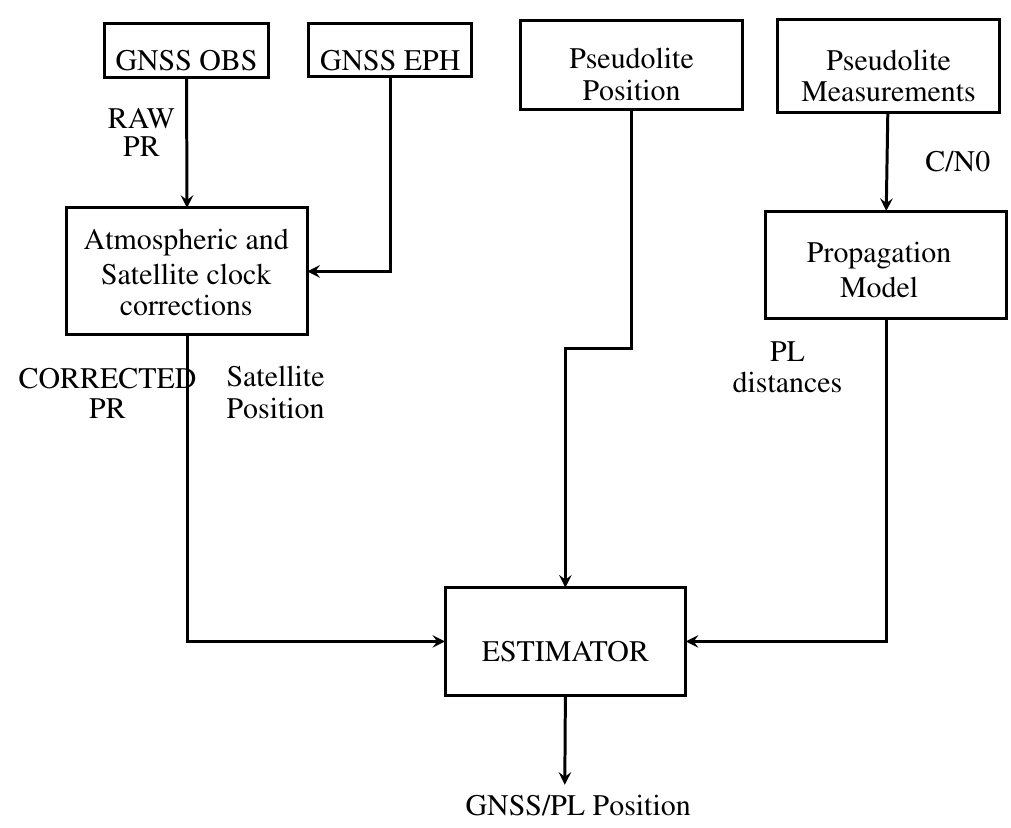
Figure 2. Tightly-coupled integration flow